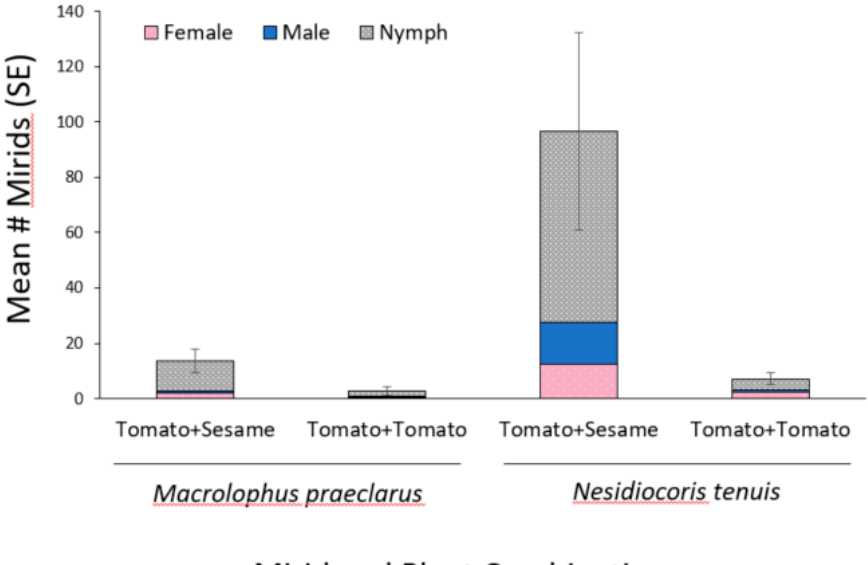
Figure 3. Mean ( ± SE) number of Macrolophus praeclarus and Nesidiocoris tenuis nymphs, males and females found in cages with two clean (no whitefly prey added) tomato plants or one tomato and one sesame plant five weeks after adding four adult mirids (two males and two females).